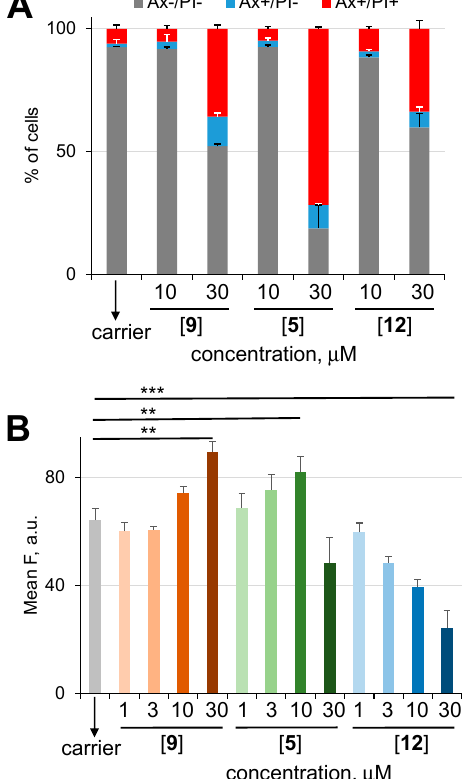
Figure 5. A : Effect of prodrug 5 and controls 9 and 12 used at the indicated on the plot concentrations on the viability of Jurkat cells (incubation time: 48 h). The cells were stained and analyzed by flow cytometry as described in the SI. Annexin A5-FITC (Ax) and propidium iodide (PI) negative cells (indicated “Ax-/PI-“) were considered viable, “Ax+/PI-“—apoptotic and “Ax+/PI+” necrotic. B : Effect of prodrug 5 and controls 9 and 12 used at the indicated on plot concentrations (incubation time: 48 h) on mitochondrial membrane potential of Jurkat cells. Fluorescence intensity corresponding to the potential-sensitive dye 1,1 ′ ,3,3,3 ′ ,3 ′ -hexamethylindodicarbocyanine iodide (DiIC1(5)) is plotted on the Y-axis ( λ ex = 638 nm; λ em = 655-695 nm). Student’s t-test: **— p < 0.01; ***— p < 0.001.